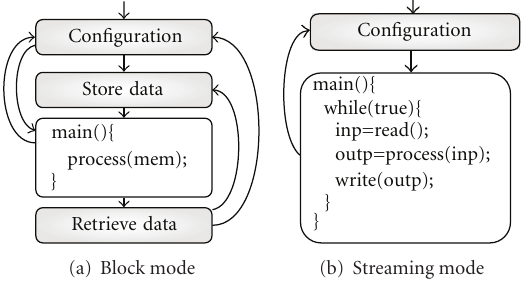
Figure 6: State transition diagrams for the two communication